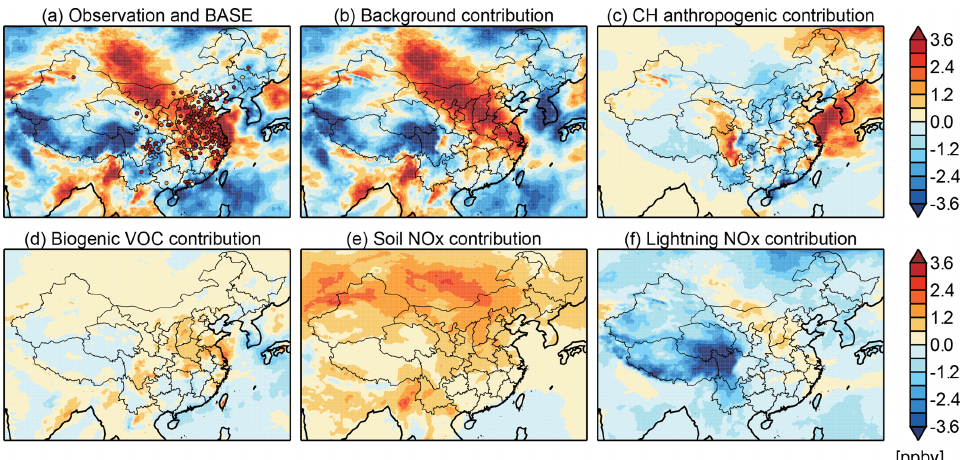
Figure 13. Differences in May–August mean (a) observed (circles) and simulated (shaded) surface MDA8 ozone concentration, (b) back- ground ozone, (c) domestic anthropogenic ozone contribution, (d) biogenic VOC ozone contribution, (e) soil NO x ozone contribution, and (f) lightning NO x ozone enhancement between 2017 and 2016.